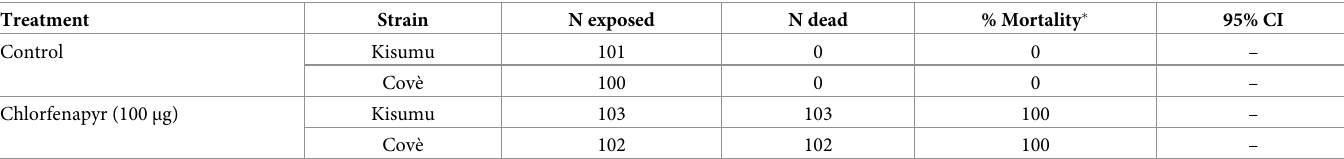
Table 2. Susceptibility of field-collected Anopheles gambiae sensu lato from Cov è to chlorfenapyr in CDC bottle bioassays.